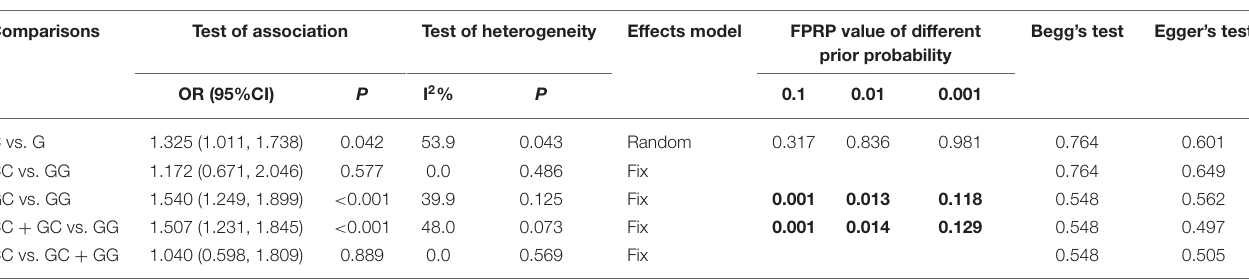
TABLE 2 | Summary of the association between MIF -173G > C polymorphism and INS susceptibility.